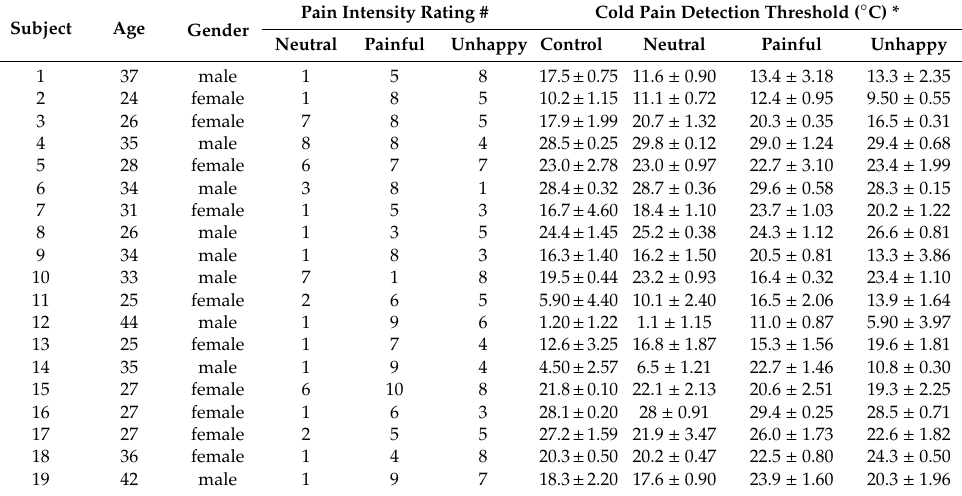
Table 1. Background Information and Measuring Data of Individual